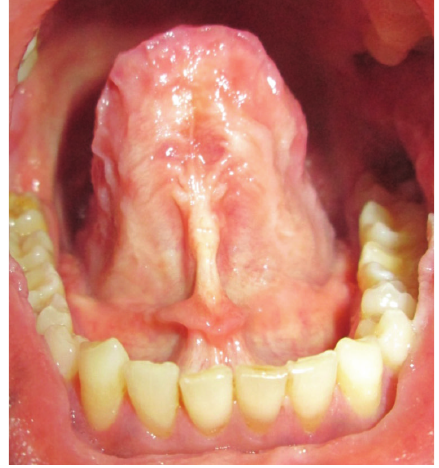
Figure 3: Sublingual frenum was stiff.